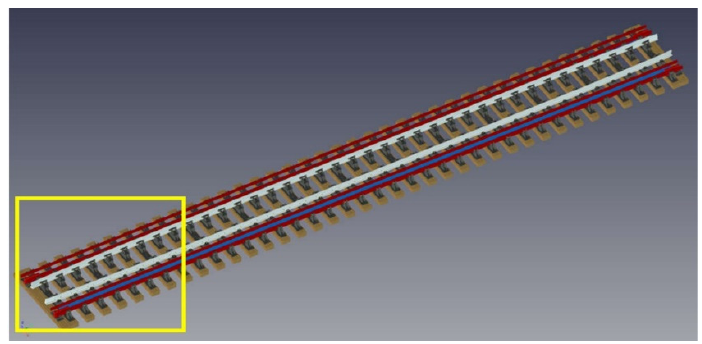
Figure 2. Releasing section of the railway track for a variable gauge system.